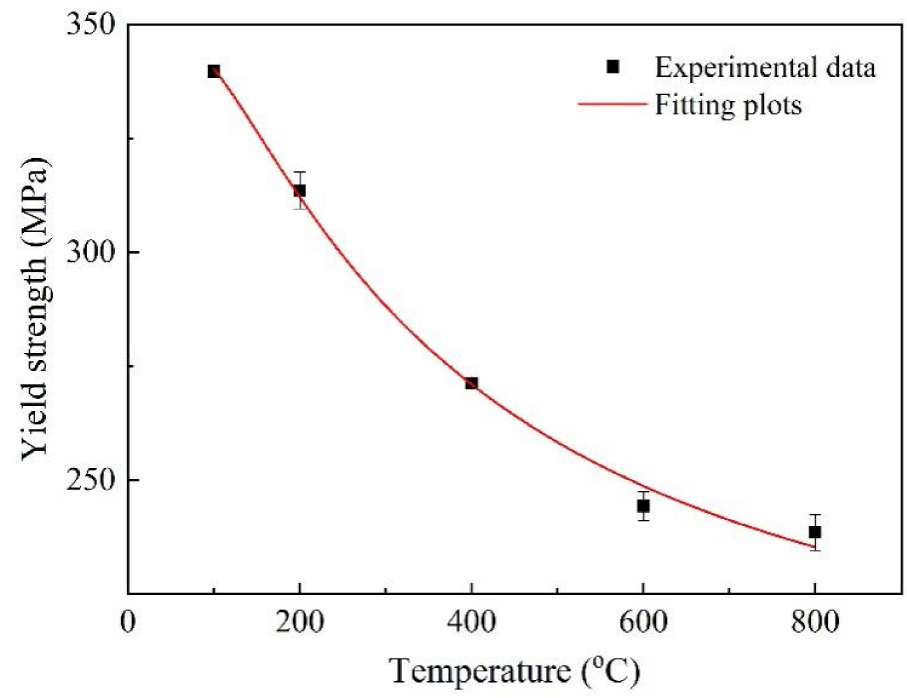
Figure 9. The experimental and fitting results of yield strength with increasing